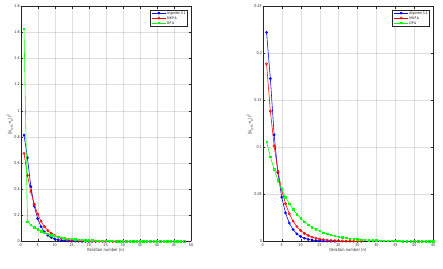
Figure 4. Example 2. Left: Case III; Right: Case